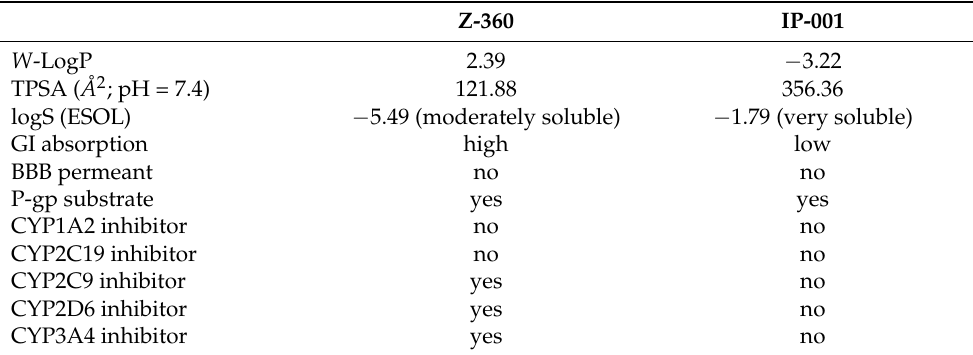
Table 1. Predicted properties for Z-360 and IP-001. W-LogP: Wildman’s logP; TPSA: topological polar surface area; GI: gastrointestinal; BBB: blood brain barrier; ESOL: Estimated aqueous SOLubility; P-gp: P-glycoprotein; CYP: P-cytochrome. Z-360 IP-001 W -LogP 2.39 121.88